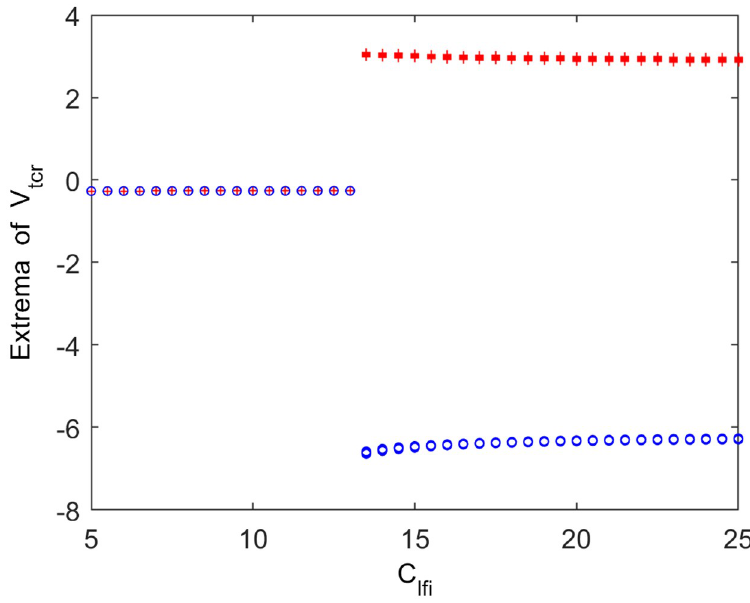
Fig 7. Bifurcation analysis of the thalamic module’s extrema for varying synaptic connection C points indicate the local maximum and minimum of the thalamic output, respectively.